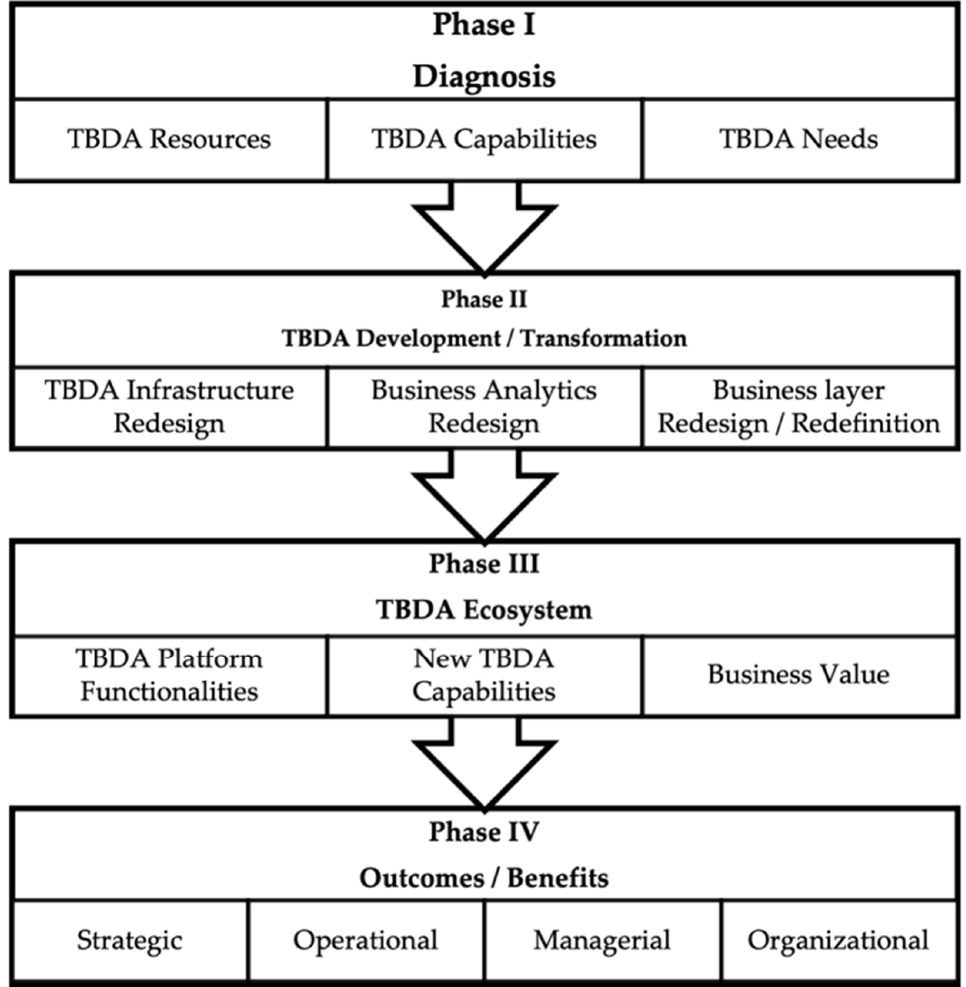
Figure 2. The general structure of the TBDA implementation framework.